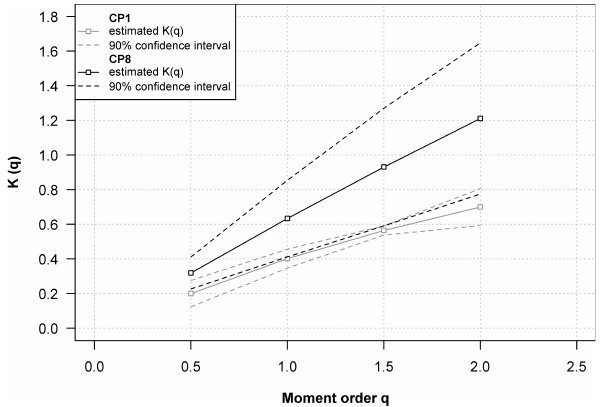
Fig. 6. Scaling exponent K(q) as estimated from the moment-scale relationship of rainfall data on days governed by CP 1 and CP 8 in the period 1989–1999 for moments of order q ={ 0.5, 1, 1.5, 2 } .